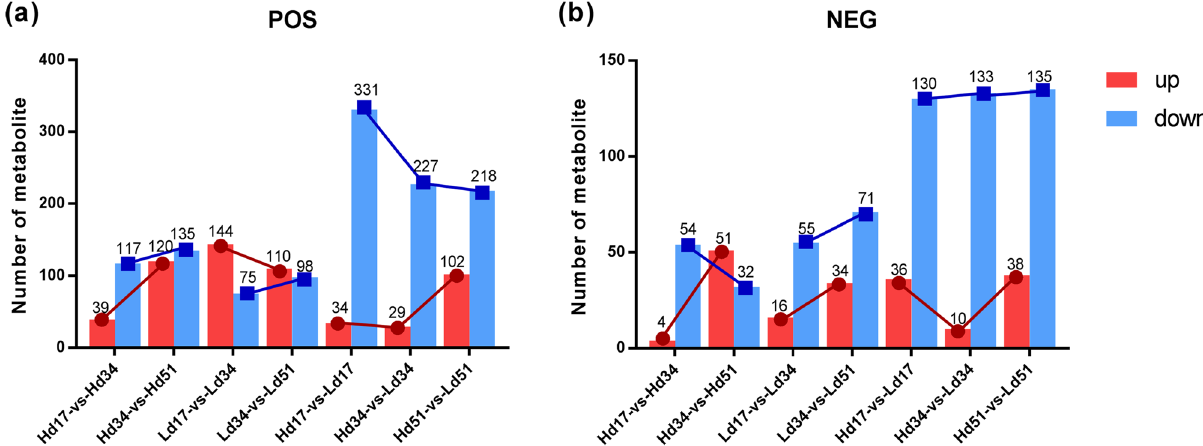
Figure 1. Differential statistics of ( a ) POS metabolites and ( b ) NEG